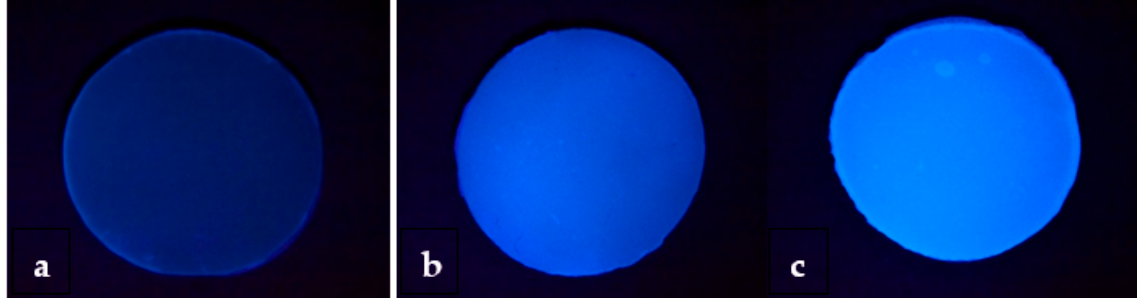
Figure 5. Samples under an ultraviolet light source showing the different fluorescence levels of the materials. Samples with different values: ( a ) low fluorescence (value 0); ( b ) medium fluorescence (value 1); ( c ) high fluorescence (value 2).